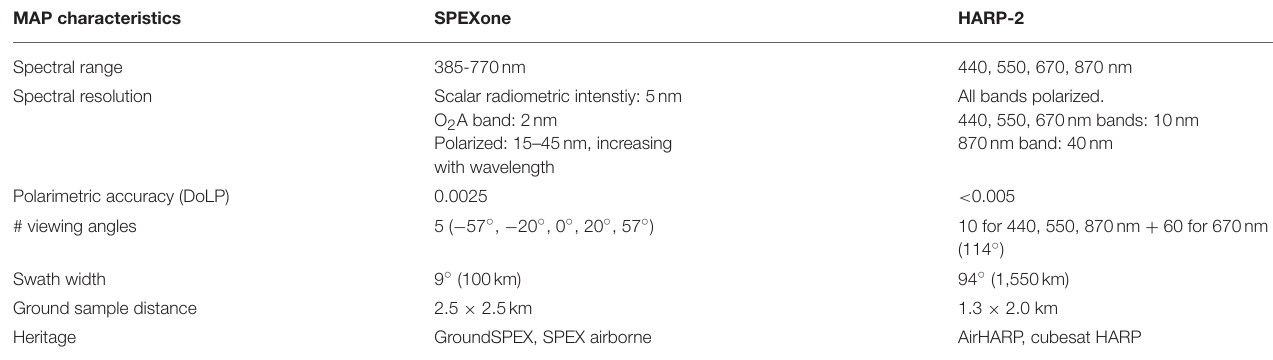
TABLE 1 | Characteristics of the two PACE